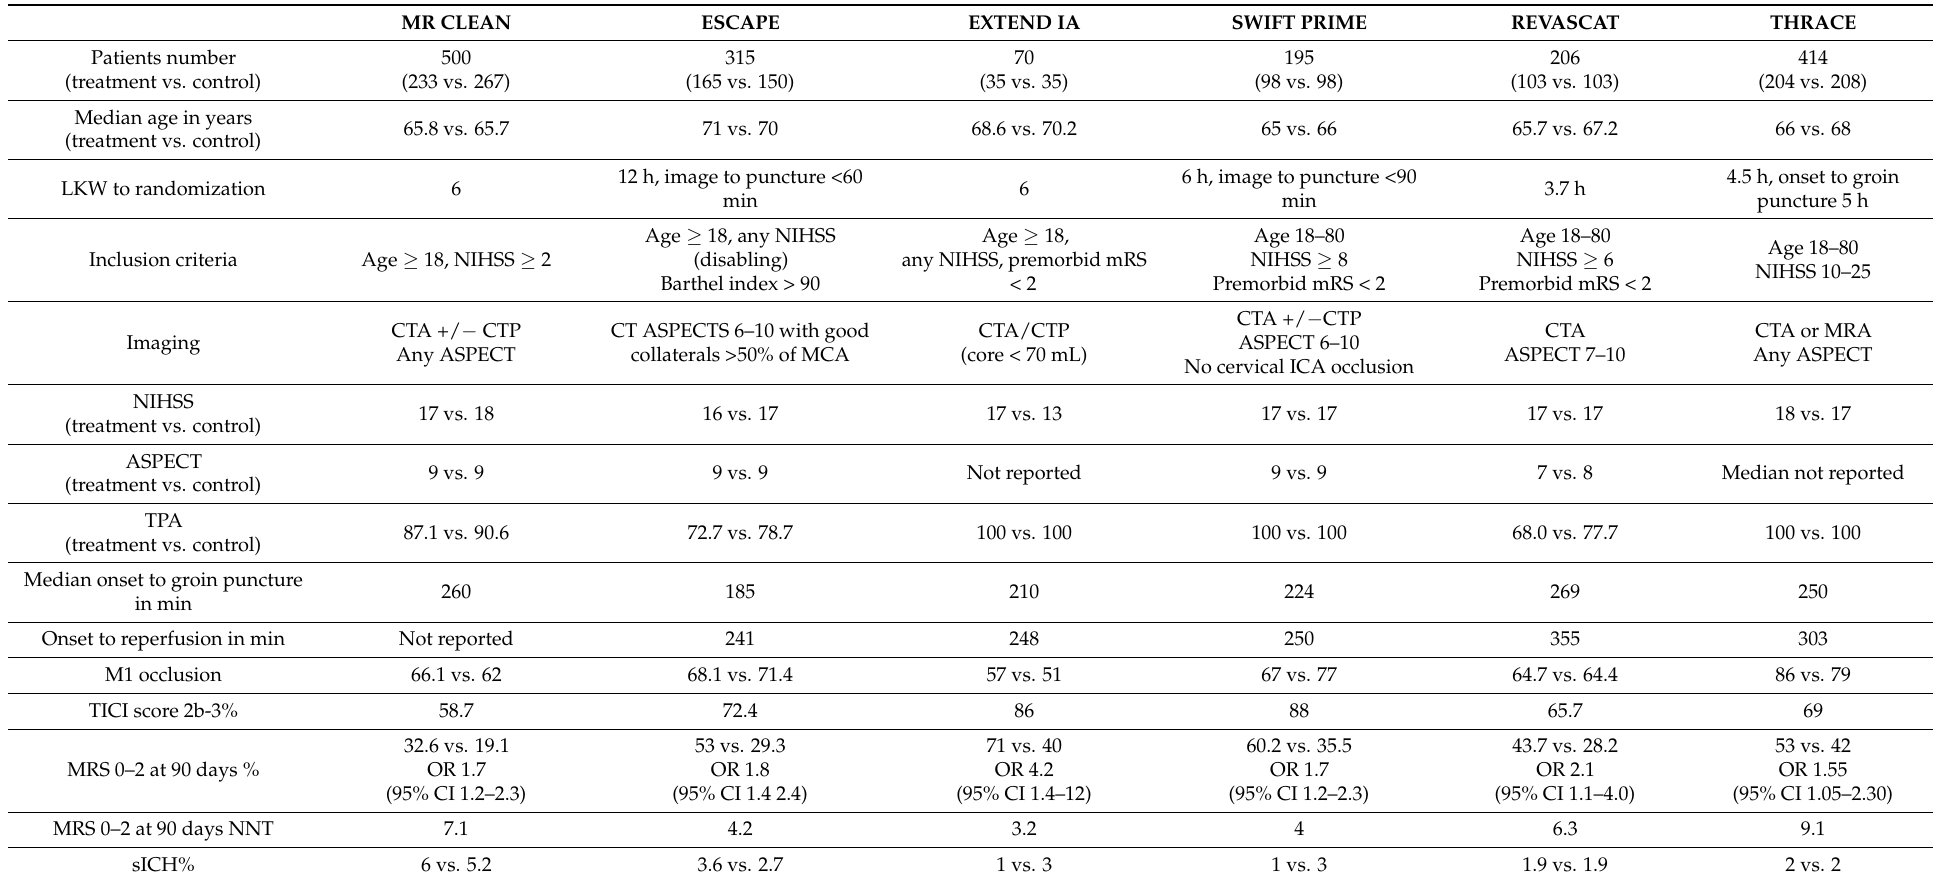
Table 2. Summary of the Main Trials Evaluating Mechanical Thrombectomy with Retrievable Stents for Acute Ischemic